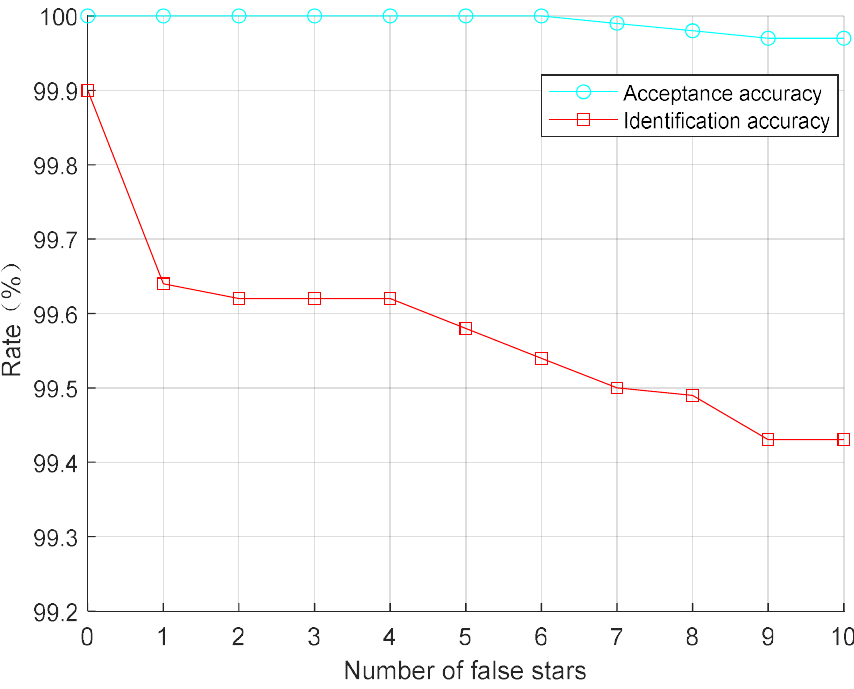
Figure 22. Acceptance accuracy and identification accuracy sensitivity to false stars.